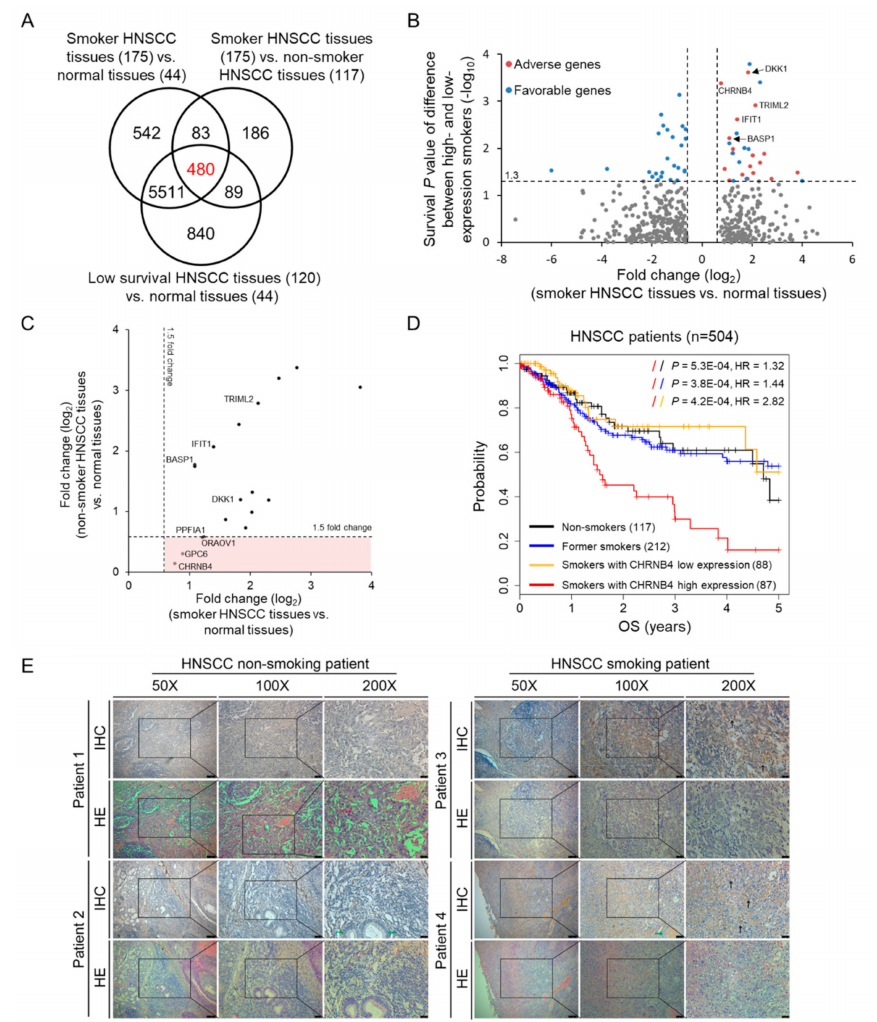
Figure 2. The strategies for determining HNSCC smoking-related and prognostic biomarkers. ( A ) Venn diagram of di ff erentially expressed genes (DEGs) among normal samples, and HNSCC